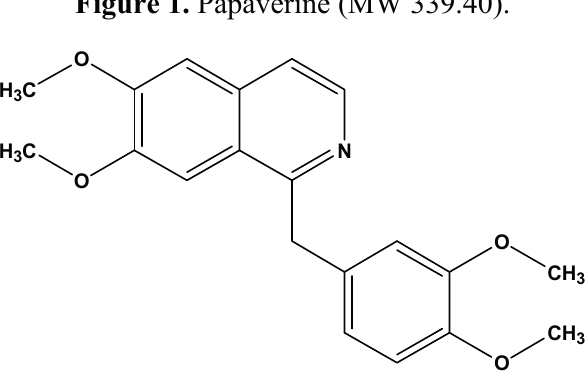
Figure 1. Papaverine (MW